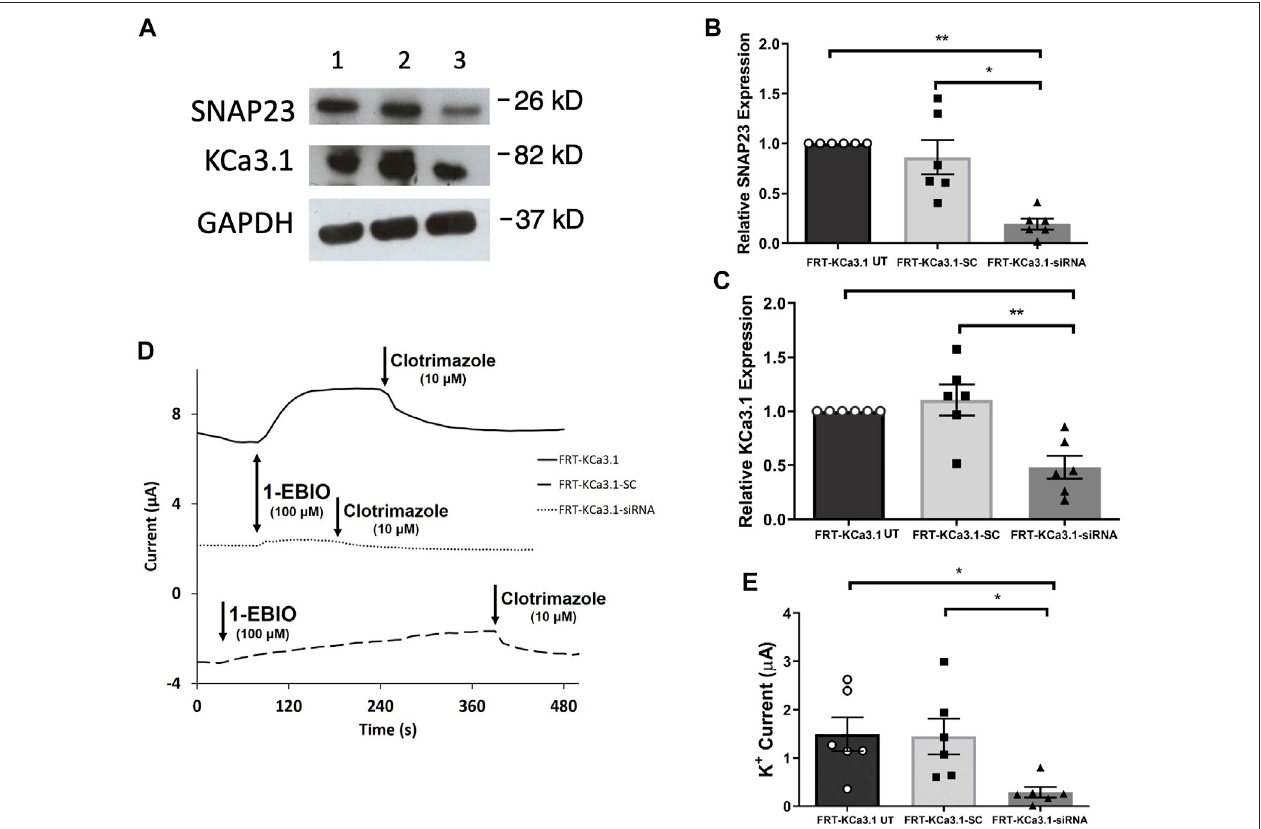
FIGURE 3 | The membrane expression and function of KCa3.1 in response to the siRNA knockdown of SNAP-23. FRT-KCa3.1-BLAP cells were reverse transfected (20 pM, 48 h) with a scrambled siRNA (FRT-KCa3.1-SC) or siRNA to knock down SNAP-23 (FRT-KCa3.1-siRNA). (A) FRT-KCa3.1 UT (untransfected with any siRNA,UT),FRT-KCa3.1-SC,andFRT-KCa3.1-siRNAcellswererunbyimmunoblot(8%gel).Lanes wereloadedwith30 μ gofprotein. SNAP-23and KCa3.1were detected in FRT-KCa3.1 cells. Lane 1: FRT-KCa3.1 UT, Lane 2: FRT-KCa3.1-SC, and Lane 3: FRT-KCa3.1-siRNA. GAPDH was used as a loading control. (B) SNAP-23 expression in FRT-KCa3.1-siRNAcells wasreducedby 77±5% ( n = 6,* p ≤ 0.05) withrespect to FRT-KCa3.1-SC cells. (C) Inthe presence ofknockdownof SNAP-23, the KCa3.1 membrane expression in FRT-KCa3.1-siRNA cells was reduced by 56 ± 7% ( n = 6, ** p ≤ 0.01) with respect to FRT-KCa3.1-SC cells. (D) Ussing chamber experiment of FRT-KCa3.1 cells with SNAP-23 knock down. Representative traces of control FRT-KCa3.1 (black line), FRT-KCa3.1-SC control (dashed line) and FRT-KCa3.1-siRNA cells (dotted line) are shown. 1-EBIO promoted a signi fi cantly reduced K + current in the FRT-KCa3.1-siRNA cells compared to control FRT- KCa3.1UTcellsortheFRT-KCa3.1-SCcontrolcells.Thiscurrentwasabatedbyclotrimazole(10 µM). (E) BargraphofK + currentofcontrolFRT-KCa3.1, FRT-KCa3.1- SC and FRT-KCa3.1-siRNA cells treated with 1-EBIO. FRT-KCa3.1-siRNA cells demonstrated a signi fi cantly reduced current by 80 ± 11% compared to FRT-KCa3.1- SC cells ( n = 6, * p ≤